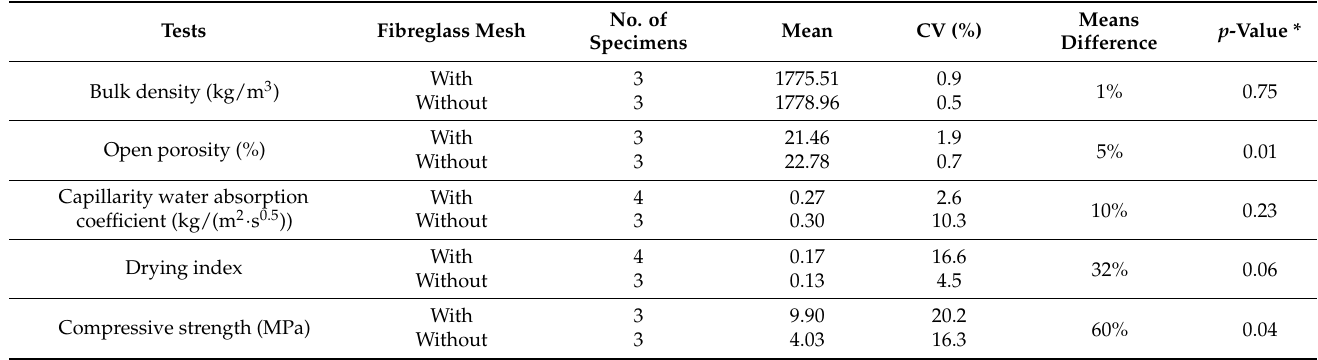
Table 10. Hydraulic lime mortar applied to the natural stone